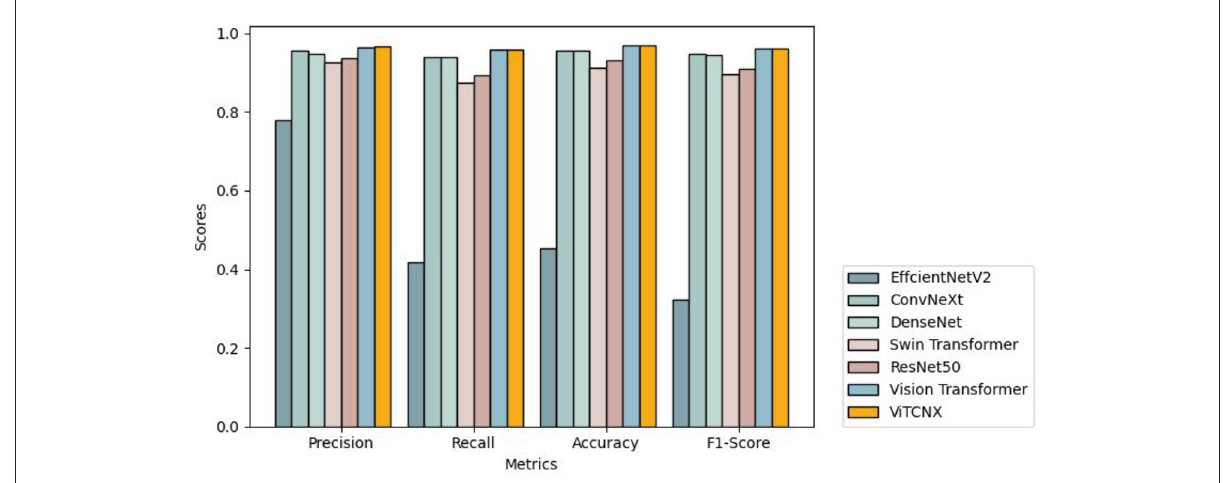
FIGURE8 The performance of VitCNX and six other models for three-classification